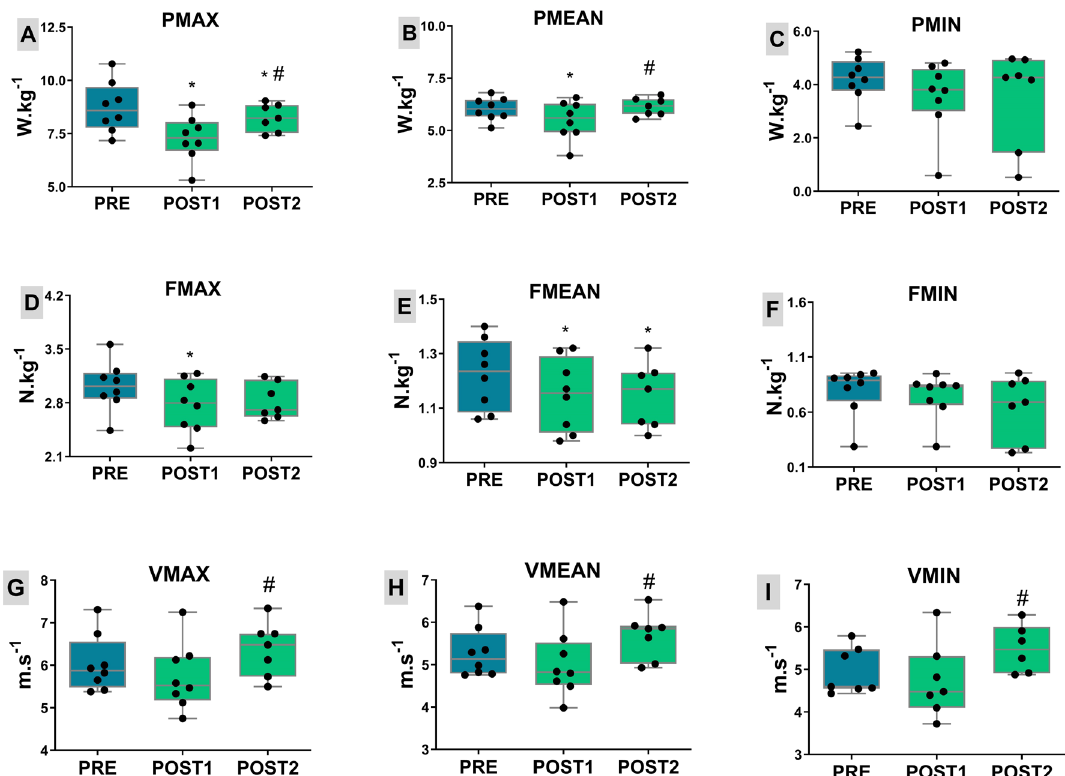
Figure 5. Mechanical results obtained during tethered running before (PRE—blue bar) and at two moments after altitude exposure (POST—green bar). Box plots depict median value (line in the box) with box edges representing 25th–75th percentiles and whiskers showing range of values (min to max) for maximum power (PMAX, A ), mean power (PMEAN, B ), minimum power (PMIN, C ), maximum force (FMAX, D ), mean force (FMEAN, E ), minimum force (FMIN, F ), maximum velocity (VMAX, G ), mean velocity (VMEAN, H ) and minimum velocity (VMIN, I ). Power and force data were normalized by body mass. * Different of PRE, # different of POST1 (according to repeated ‐ measures ANOVA using Newman–Keuls post-hoc